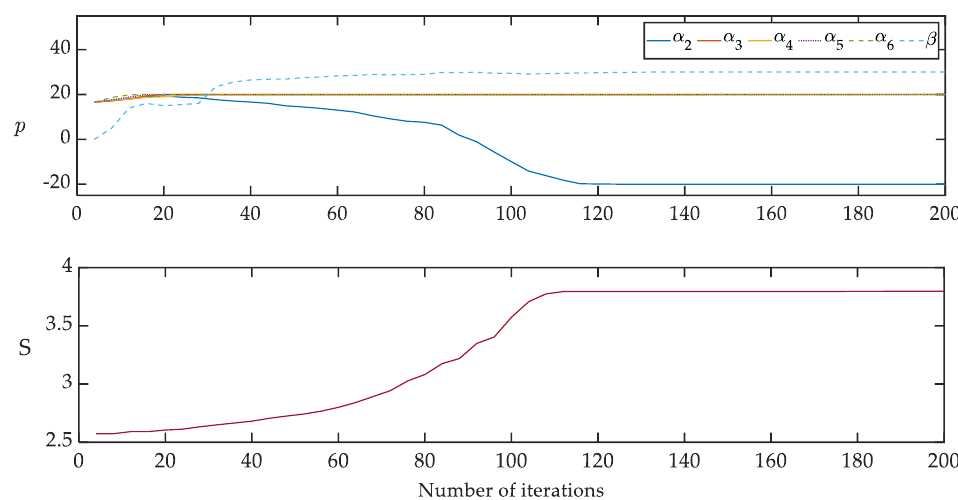
Figure 9. Optimization output: plot of actuator’s tilting angle and cost function trend against the number of iterations for actuator 1 failure and the null controllability performance requirement. Table 2. Parameter optimizations result in null controllability, single actuator failure at a time. Fault